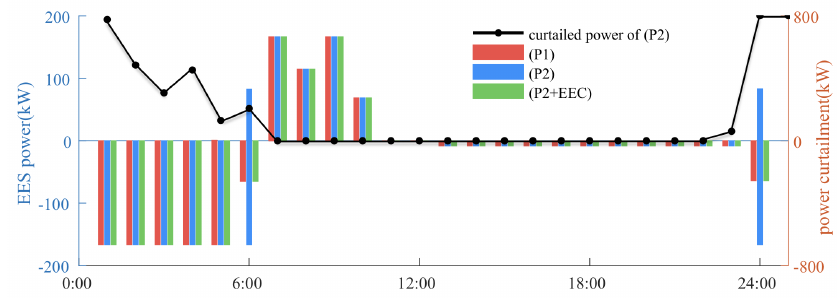
Figure 8. Power of RES curtailment and EES in a wind-rich